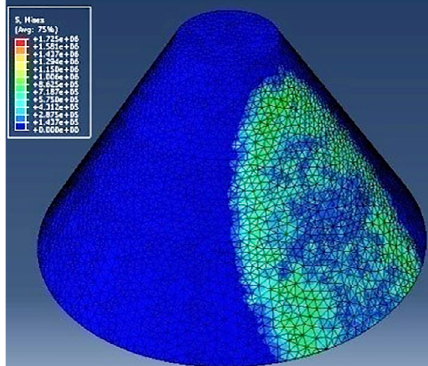
Fig. 9. Von misses composite stress contour stress in the frustum building while explosion strikes building at height of 12 meters above ground Fig. 12. Von misses composite stress contour in the conical building while explosion strikes building on the